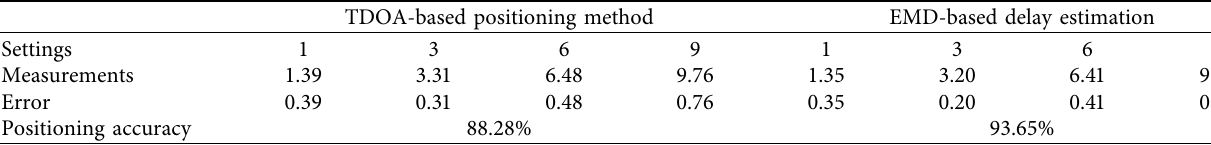
Table 2: Target localization results when the sensor distance is 3m.